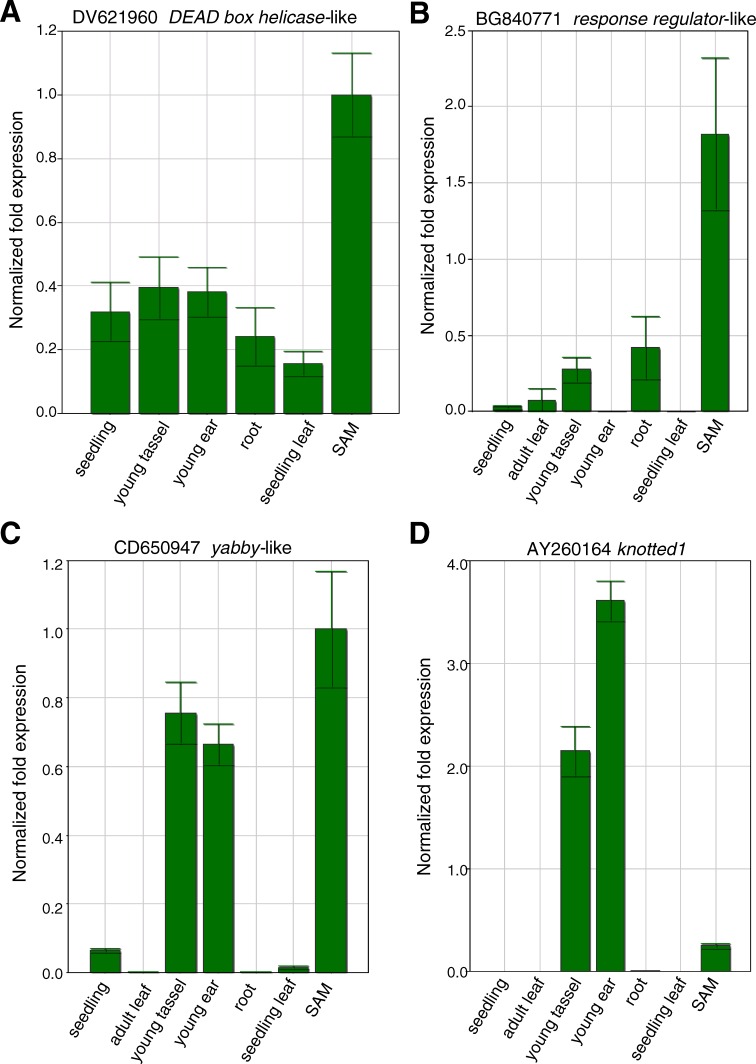
Identification of Shoot Meristem-Enriched Maize Transcripts by qRT-PCR Analyses of Multiple Maize Tissues(A) Transcripts of the DEAD box helicase-like gene DV621960 and the (B) response regulator-like gene BG840771 are enriched in the SAM, whereas (C) the yabby-like gene CD650947 is up-regulated in inflorescence tissues bearing floral meristems as well as in the SAM.(D) Control expression pattern of knotted1 is shown, which is enriched in shoot meristems.